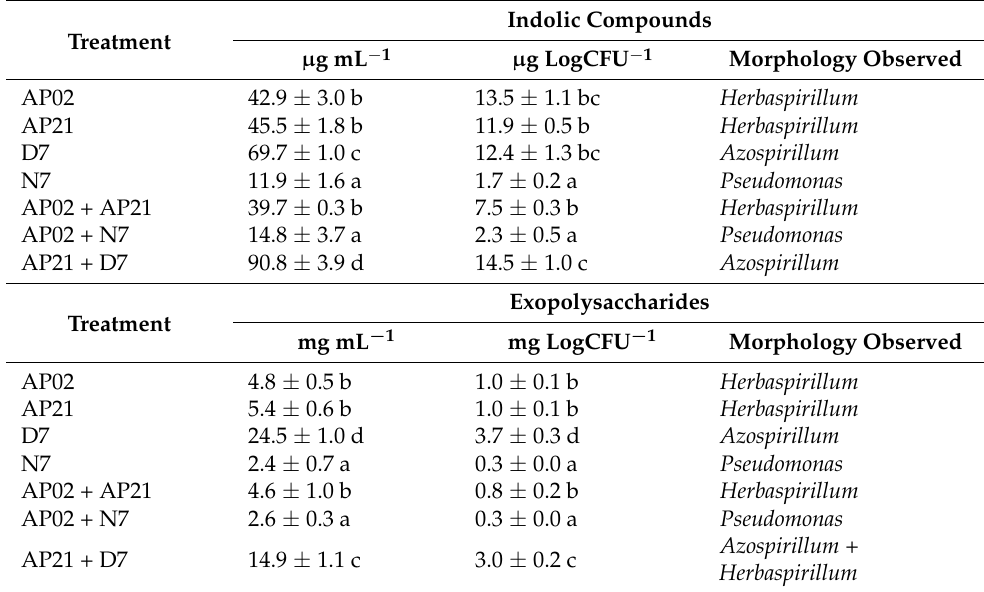
Table 2. Plant growth-promotion activities of individual and co-inoculated strains. The data were analyzed by Kruskal–Wallis, and a Wilcoxon test ( p < 0.05) was performed to compare group means against the non-inoculated stressed treatment. The strains AP02 and AP21 correspond to the Herbaspirillum genus, and D7 and N7 to Azospirillum and Pseudomonas , respectively. CFU, colony forming